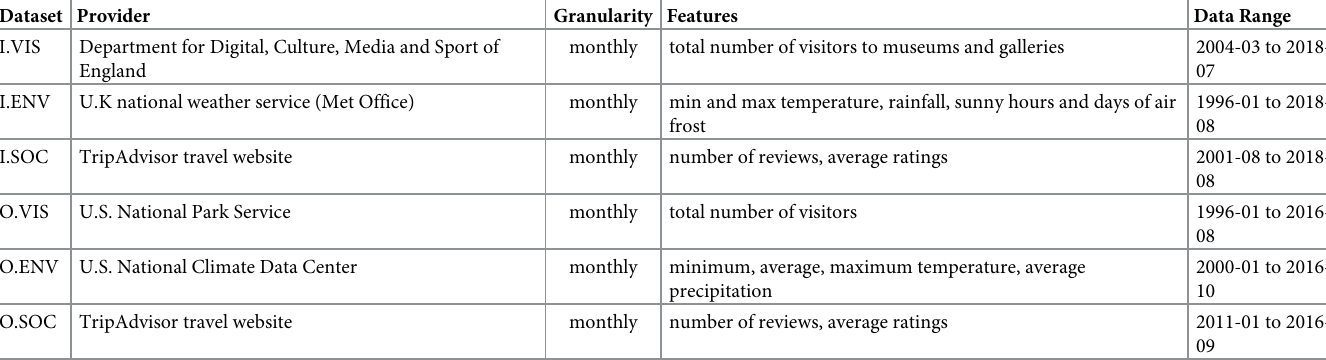
Table 2. Overview of indoors (I) and outdoors (O) datasets and features (VIS: visits, SOC: social media features, ENV: environmental features. Dataset